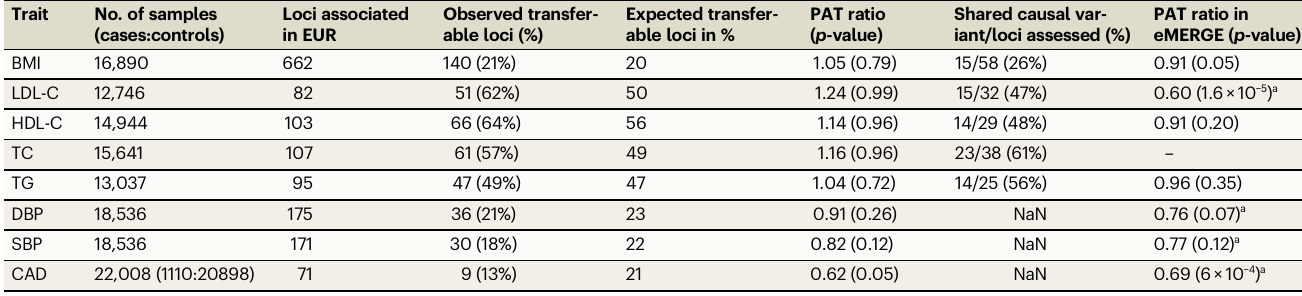
Table 1 | Transferability of loci for cardiometabolic phenotypes from European ancestry (EUR) discovery GWAS to British Pakistani and Bangladeshi individuals